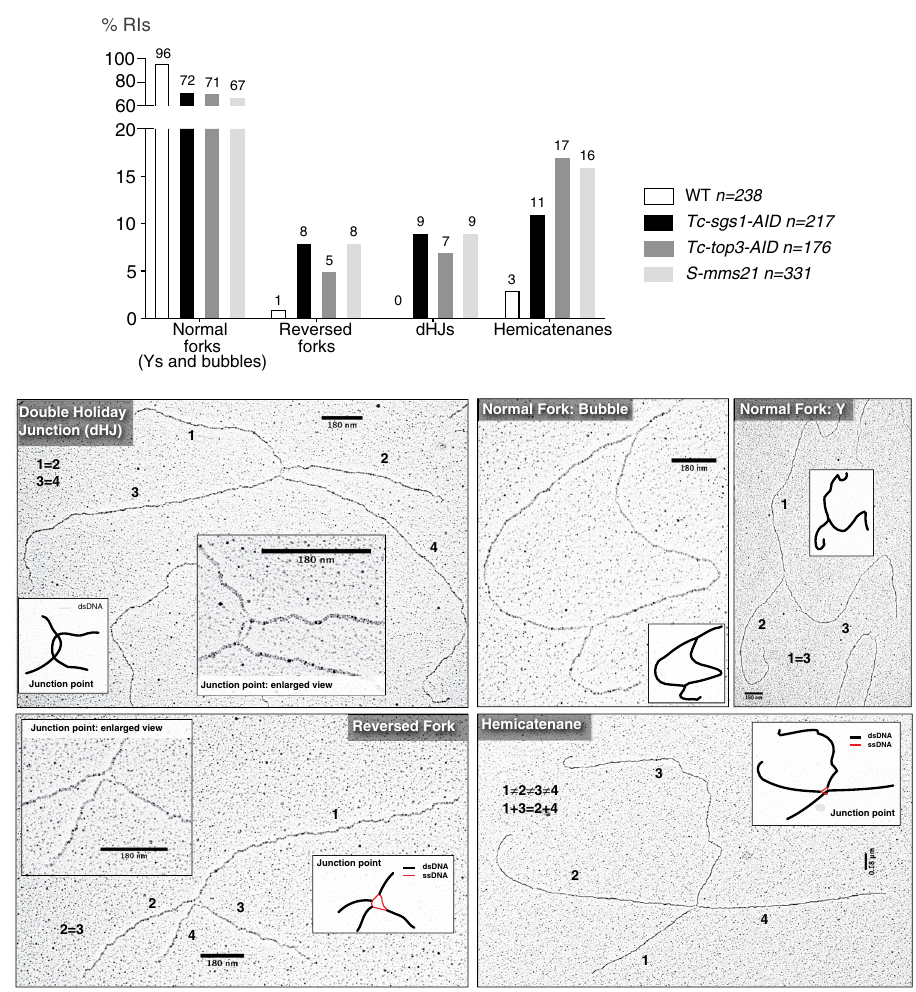
Fig. 3 STR and Smc5/6 jointly prevent accumulation of hemicatenanes, reversed forks and double Holliday Junctions. Electron microscopy analysis of replication intermediates and four-way junctions-intermediates in WT and sgs1 , top3 , smc5/6 mutants. The plot indicates the percentage of various types of DNA replication intermediates (forks and bubbles) and Joint Molecules (JMs) divided in reversed forks, double Holliday Junctions (dHJs) and hemicatenanes. The number ( n ) of DNA molecules analysed for each genotype is indicated. The intermediates are derived from two biological replicates, with similar results. Typical examples of the visualized categories of JMs are shown with the entire DNA structure and enlarged views of the junction point, with schematic representation of ssDNA regions in red and dsDNA regions in black. The length of the four branches composing the JMs and their relationship in terms of length is shown. Scale bars of 180 nm corresponding to 500 base pairs are indicated. Source data are provided as a Source Data fi